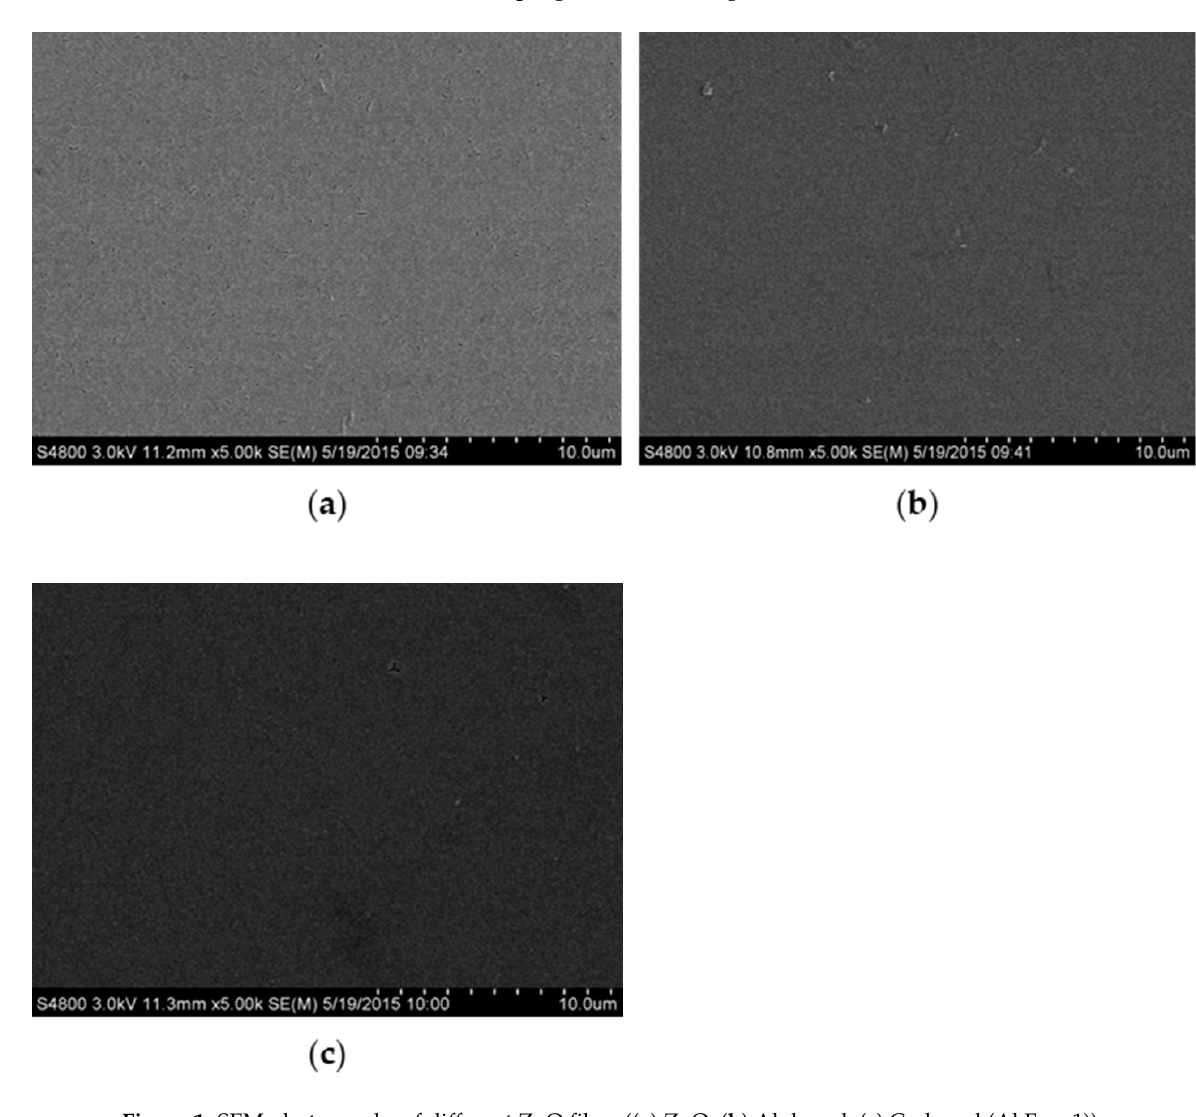
Figure 1. SEM photographs of different ZnO films (( a ) ZnO, ( b ) Al doped, ( c ) Codoped (Al:Fe = 1)). However, it can be found in Figure 3 that some diffraction peaks are moved to higher angles for the doped films. For example, the 2 θ value of (002) peaks is shifted from 34.376 ◦ for pure ZnO film to 34.552 ◦ , 34.551 ◦ , 34.552 ◦ , and 34.677 ◦ for Al doped, codoped (Al:Fe = 3), codoped (Al:Fe = 1) and codoped (Fe:Al = 3). These shifts imply that Fe and